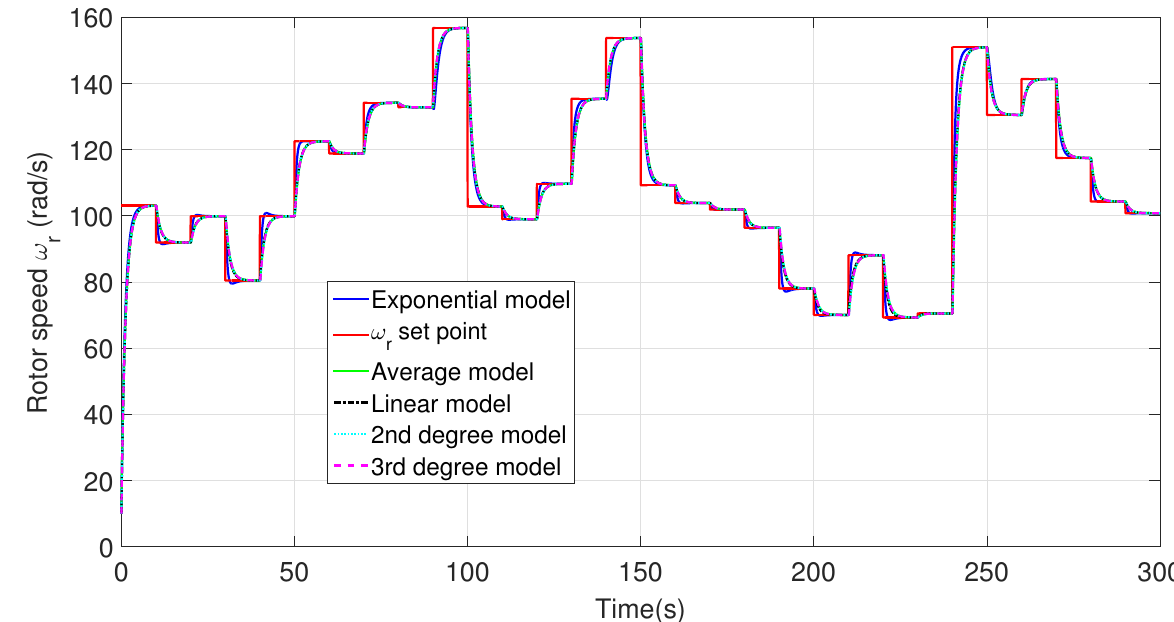
Figure 7. Whole span rotor speed control and